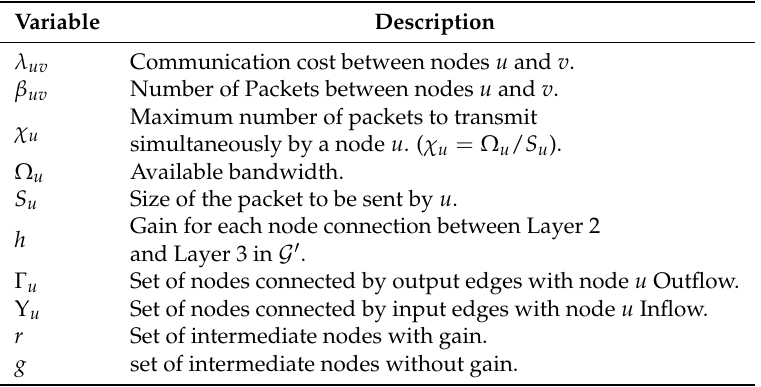
Table 1. Communication model variables.